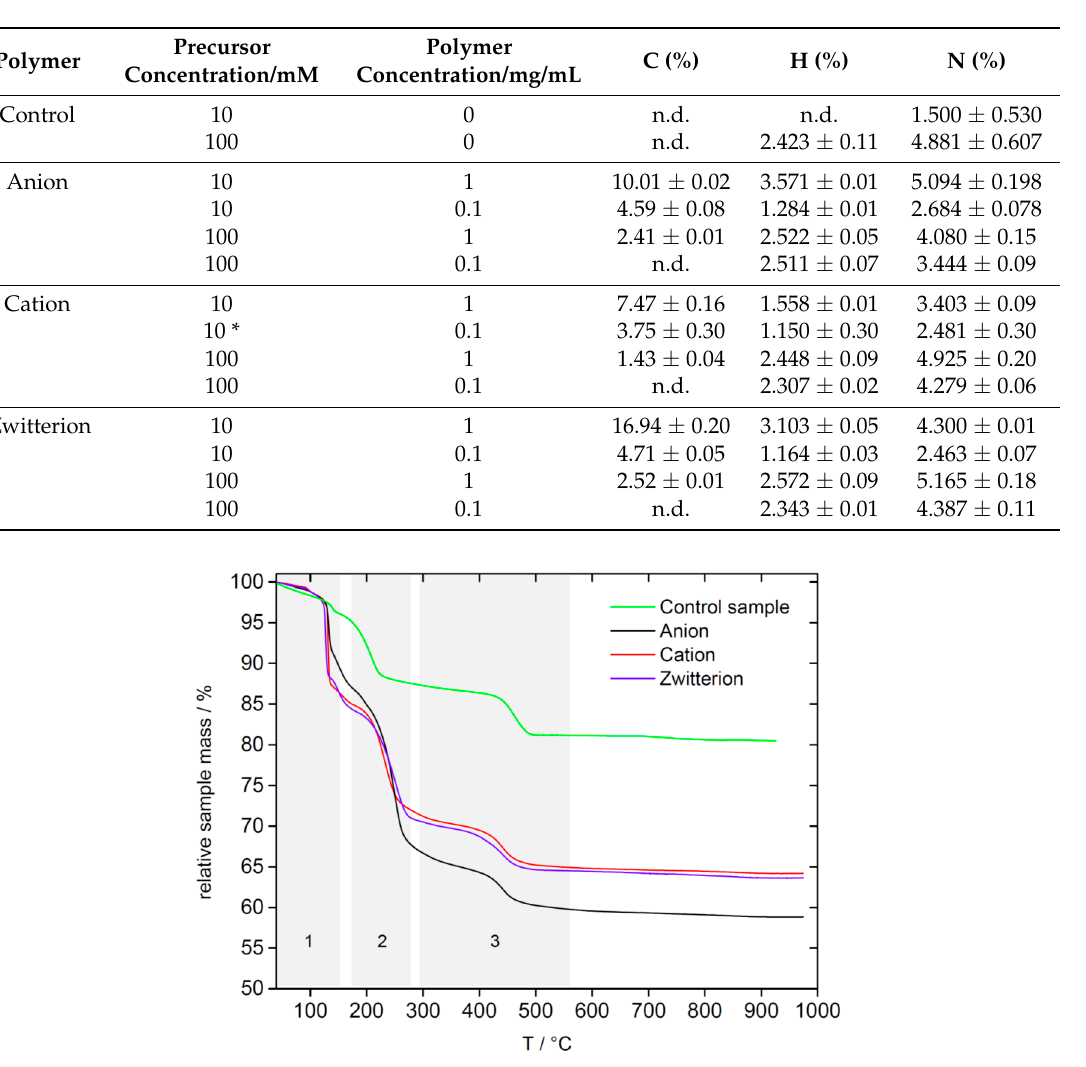
Table 1. Elemental analysis data obtained from all samples. “n.d.” (not detected) indicates elements below the detection limit of the instrument (0.30%). Asterisk * indicates a sample with limited data quality due to very low sample mass available. Error has been estimated from the instrumental resolution of the instrument.